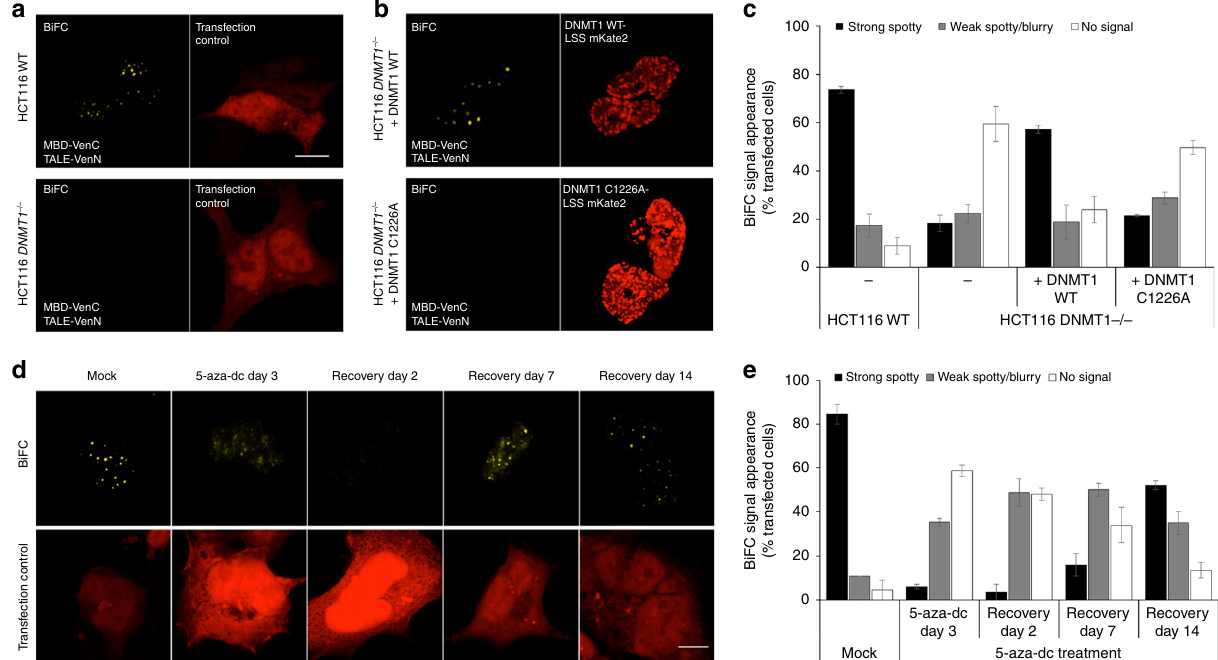
Fig. 4 Visualization of DNA methylation changes using BiAD sensor 2. a Representative fl uorescence microscopy images documenting that strong BiFC signals are formed upon transfection of the BiAD sensor 2 into HCT116 WT cells ( top ). In contrast, very low fl uorescence reconstitution was observed in DNMT1 hypomorphic HTC116 cells that have globally reduced methylation levels ( bottom ). A plasmid encoding for NLS-mRuby2 was used to identify transfected cells. b The BiFC signals were rescued in the DNMT1 hypomorphic HTC116 cells by the exogenous expression of active DNMT1 ( top ) but not of catalytically inactive DNMT1 ( bottom ). c Quanti fi cation of the experiments representatively shown in panels a , b . d Time course of DNA demethylation by treatment of HEK293 cells with 5-aza-dC and recovery. In each sample, the BiAD sensor was transfected 2 days before the cells were fi xed for imaging. e Quanti fi cation of the experiments representatively shown in panel d . Error bars in all images represent the s.e.m. for two biological replicates (for details cf . Supplementary Tables 2, 6, and 7). Scale bar for all images is 10 µ m. The imaging and display setting of the BiFC images shown in panels a , b , and d are identical. In panel d the contrast of the mRuby2 channel was increased to enhance the visibility of transfected cells. This was done with the same settings for all time